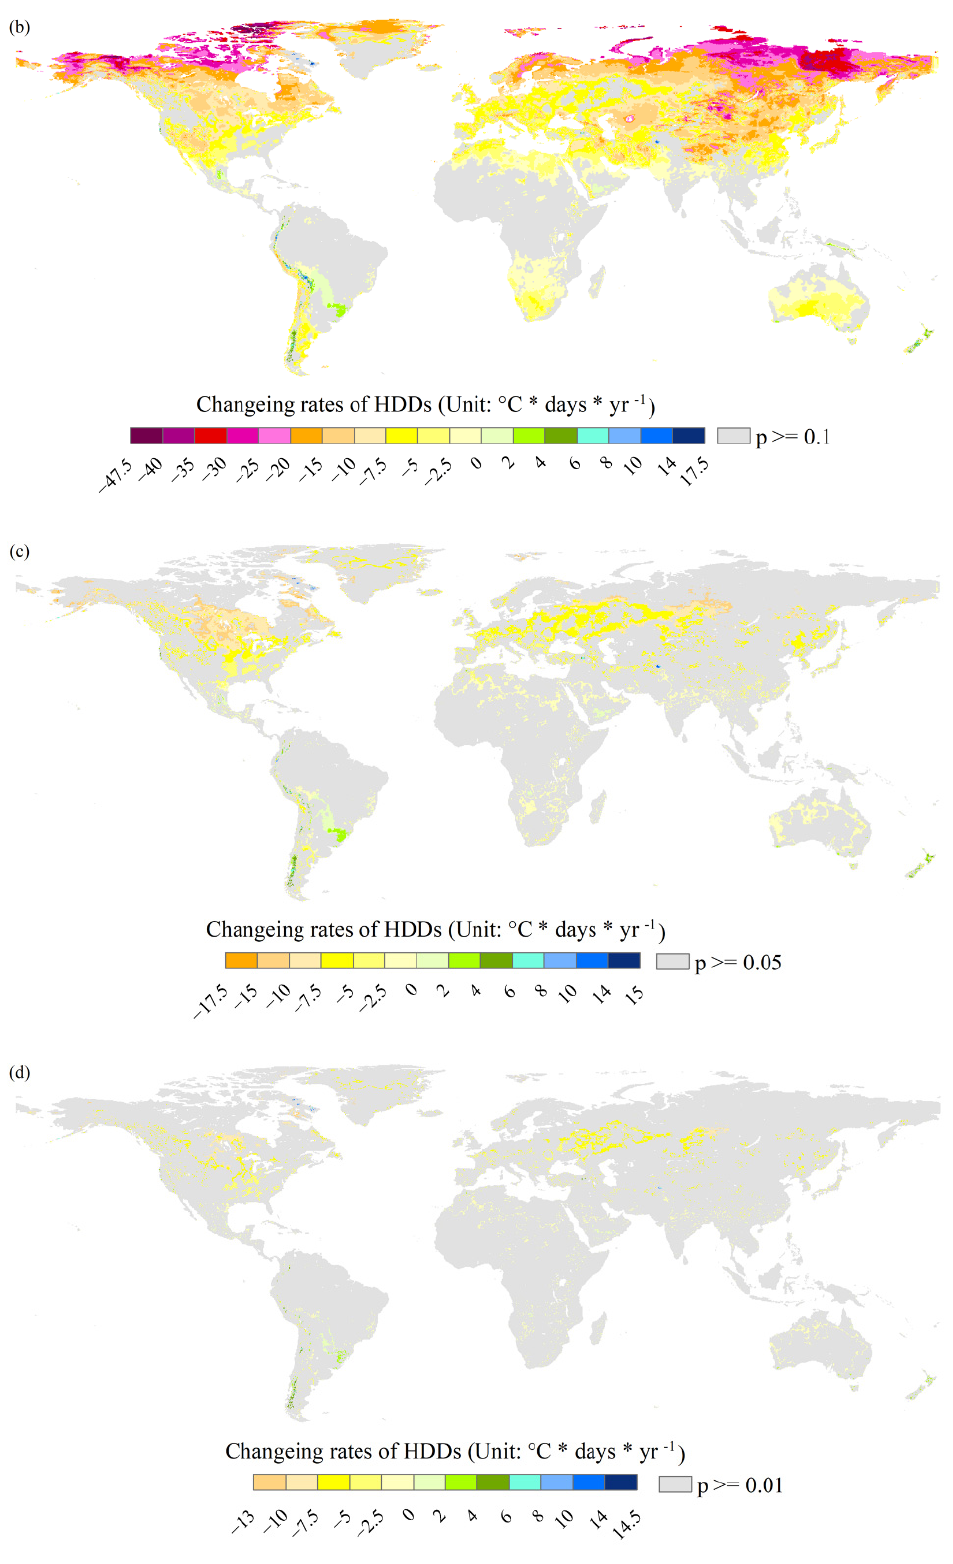
Figure 3. Change rates of global heating degree days (HDDs) from 1970 to 2018. ( a ) The significant levels of change rates of HDDs are not considered. ( b – d ) Only change rates at the 0.1, 0.05, and 0.01 levels are considered, respectively.